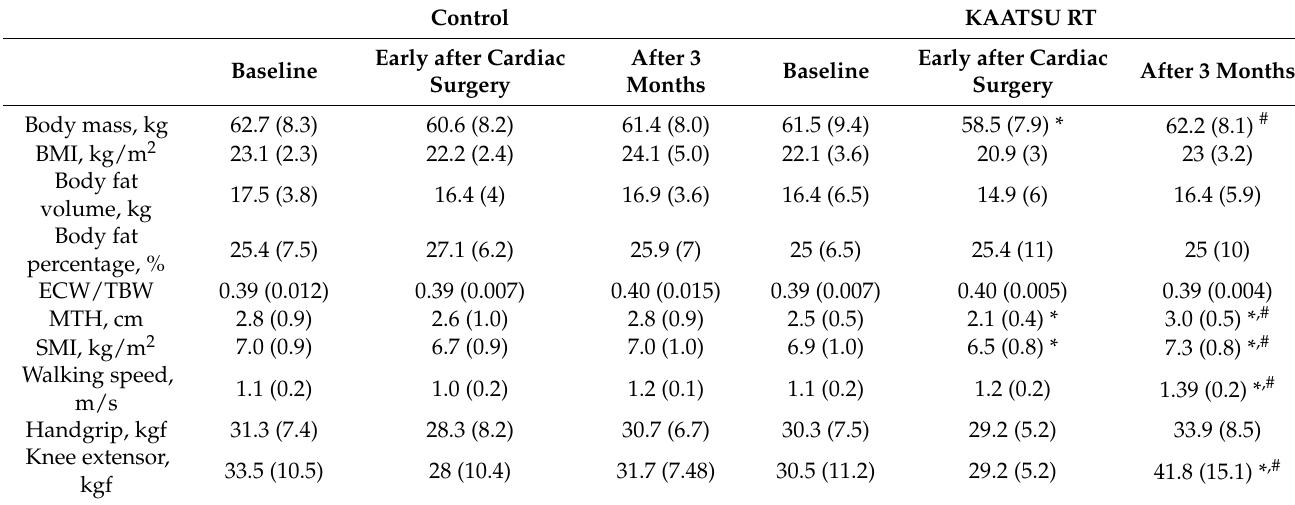
Table 3. Changes of morphological and physical function data in the two